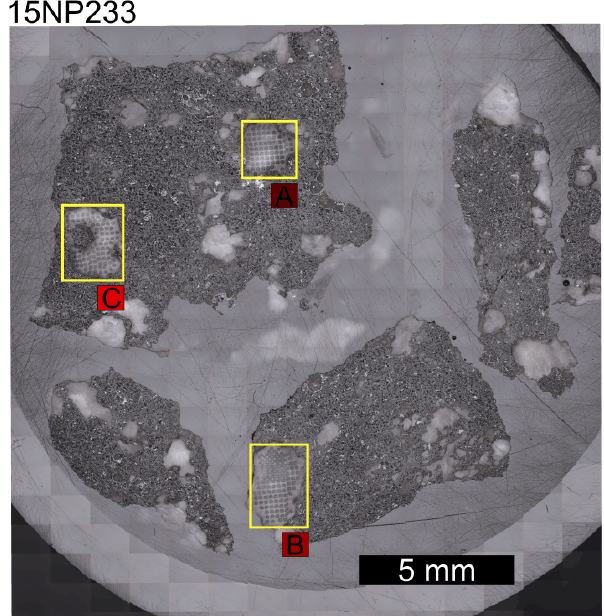
Figure A3. Reflected light image of sample 15NP233 with marked ablation areas. Letter, attached to the yellow boxes, appended to the sample name, labels the ablation areas. Colors of label boxes are consistent with colors of in-text figures.